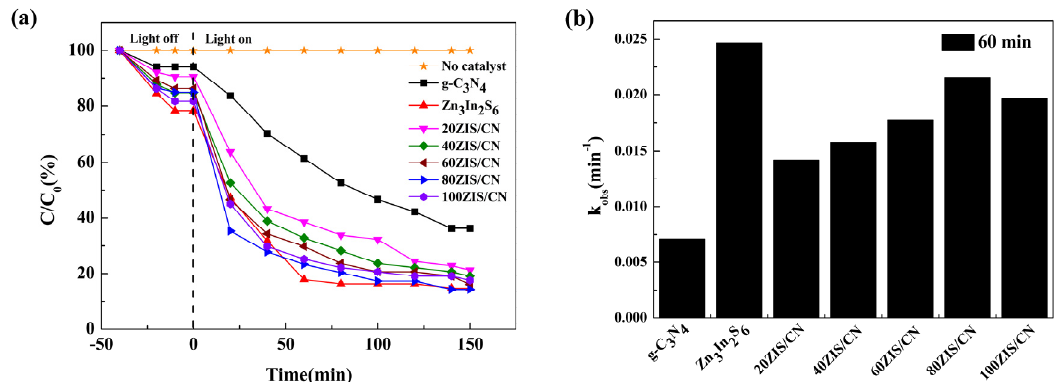
Figure 6. EIS Nyquist plot of g ‐ C 3 N 4 , Zn 3 In 2 S 6 , 80ZIS/CN.